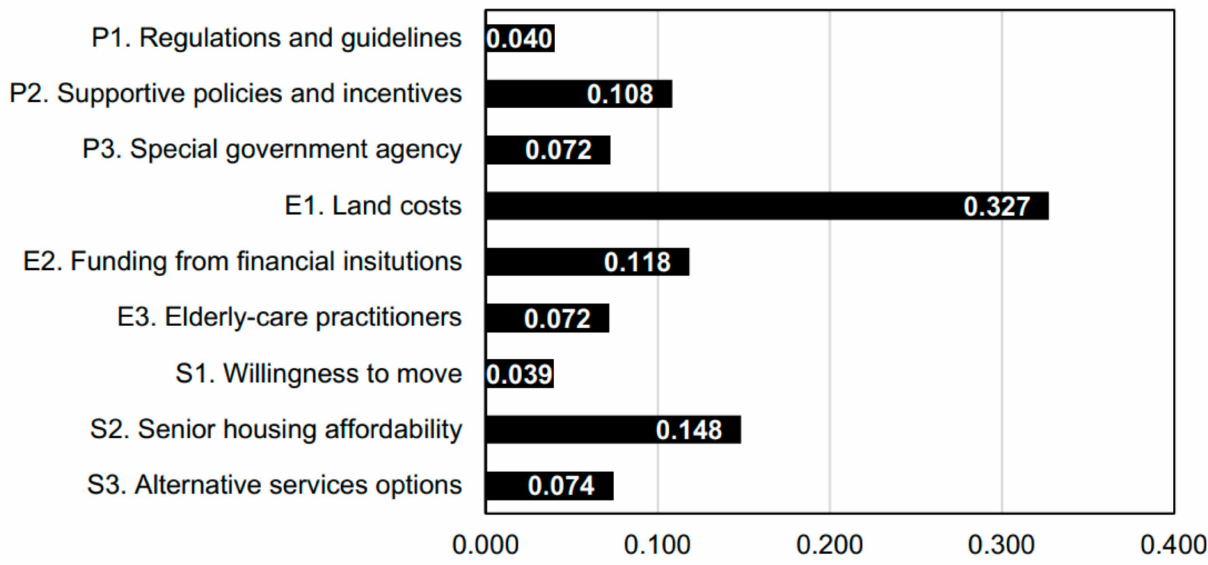
Figure 4. The global weights of the factors affecting senior housing